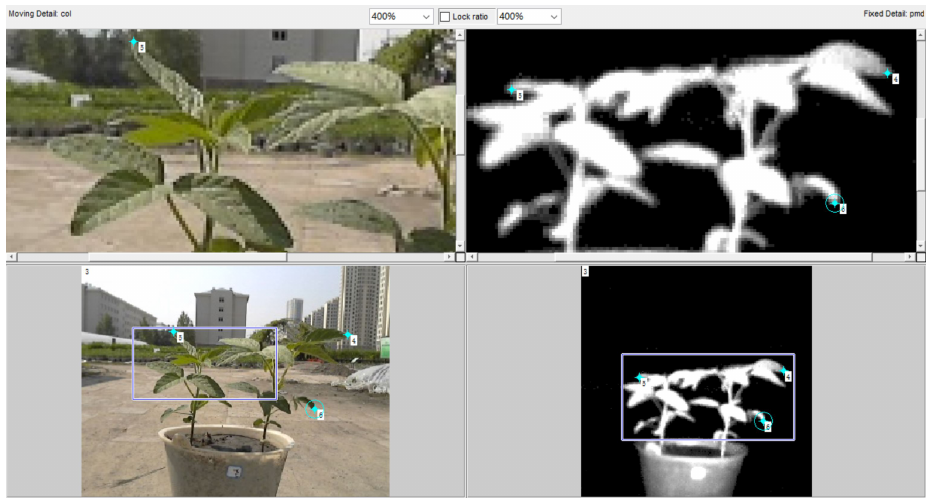
Figure 7. Control point selection